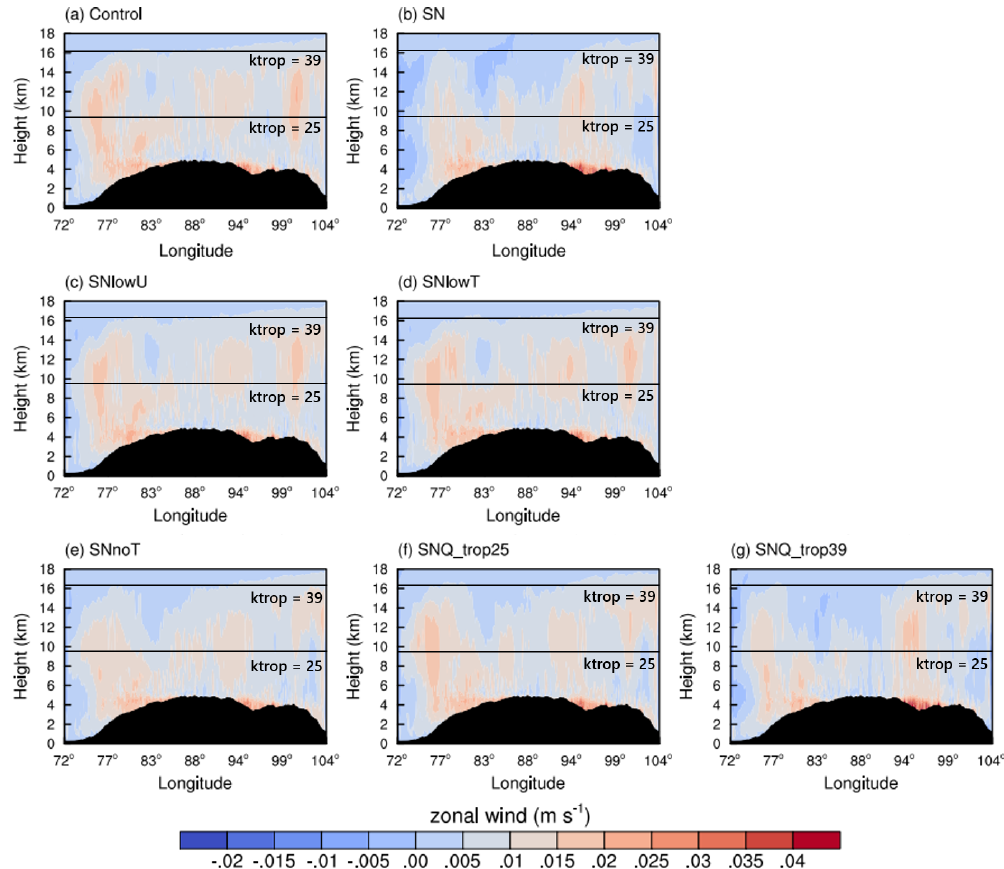
Figure 8. The same as Fig. 7 but along the average fields of 26–34 ◦